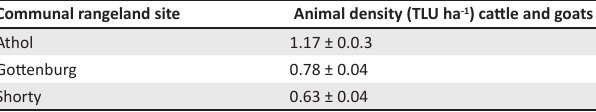
TABLE 1-A1: Livestock densities of the three communal rangeland sites. Data on livestock densities were obtained from the State Veterinary Department, originally collected by the Mnisi Community Programme, and represent a five- year mean ± standard error (SE) (2012-2016). Communal rangeland site